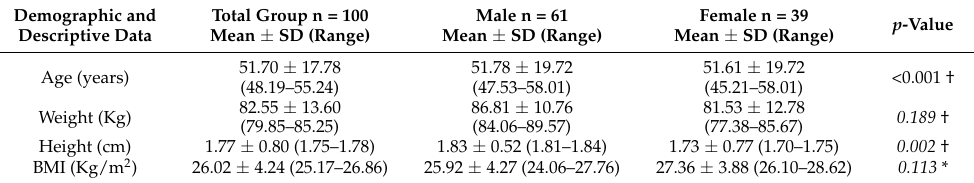
Table 1. Demographic and descriptive data of the sample population by sex.